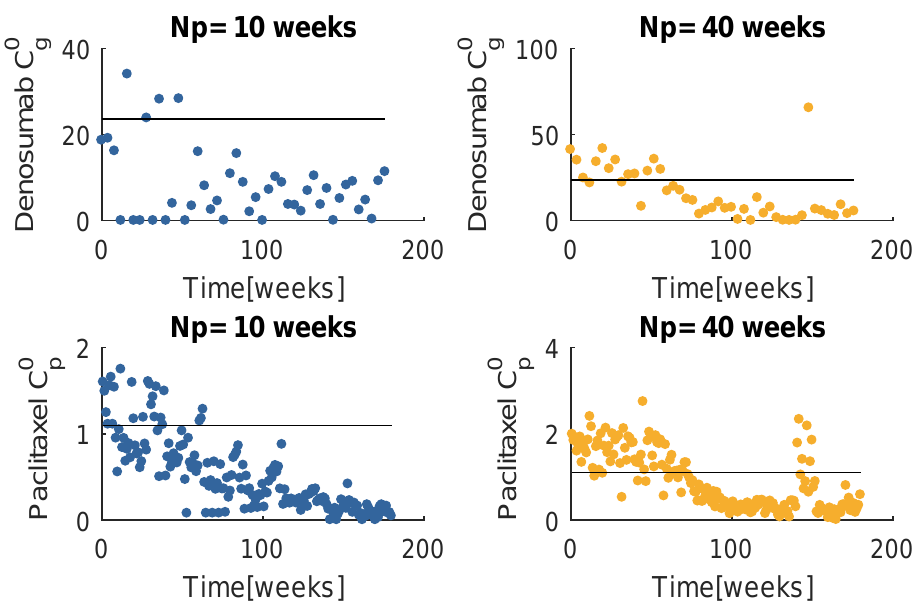
Figure 19. Best obtained prescriptions in mg with the model M DR 2